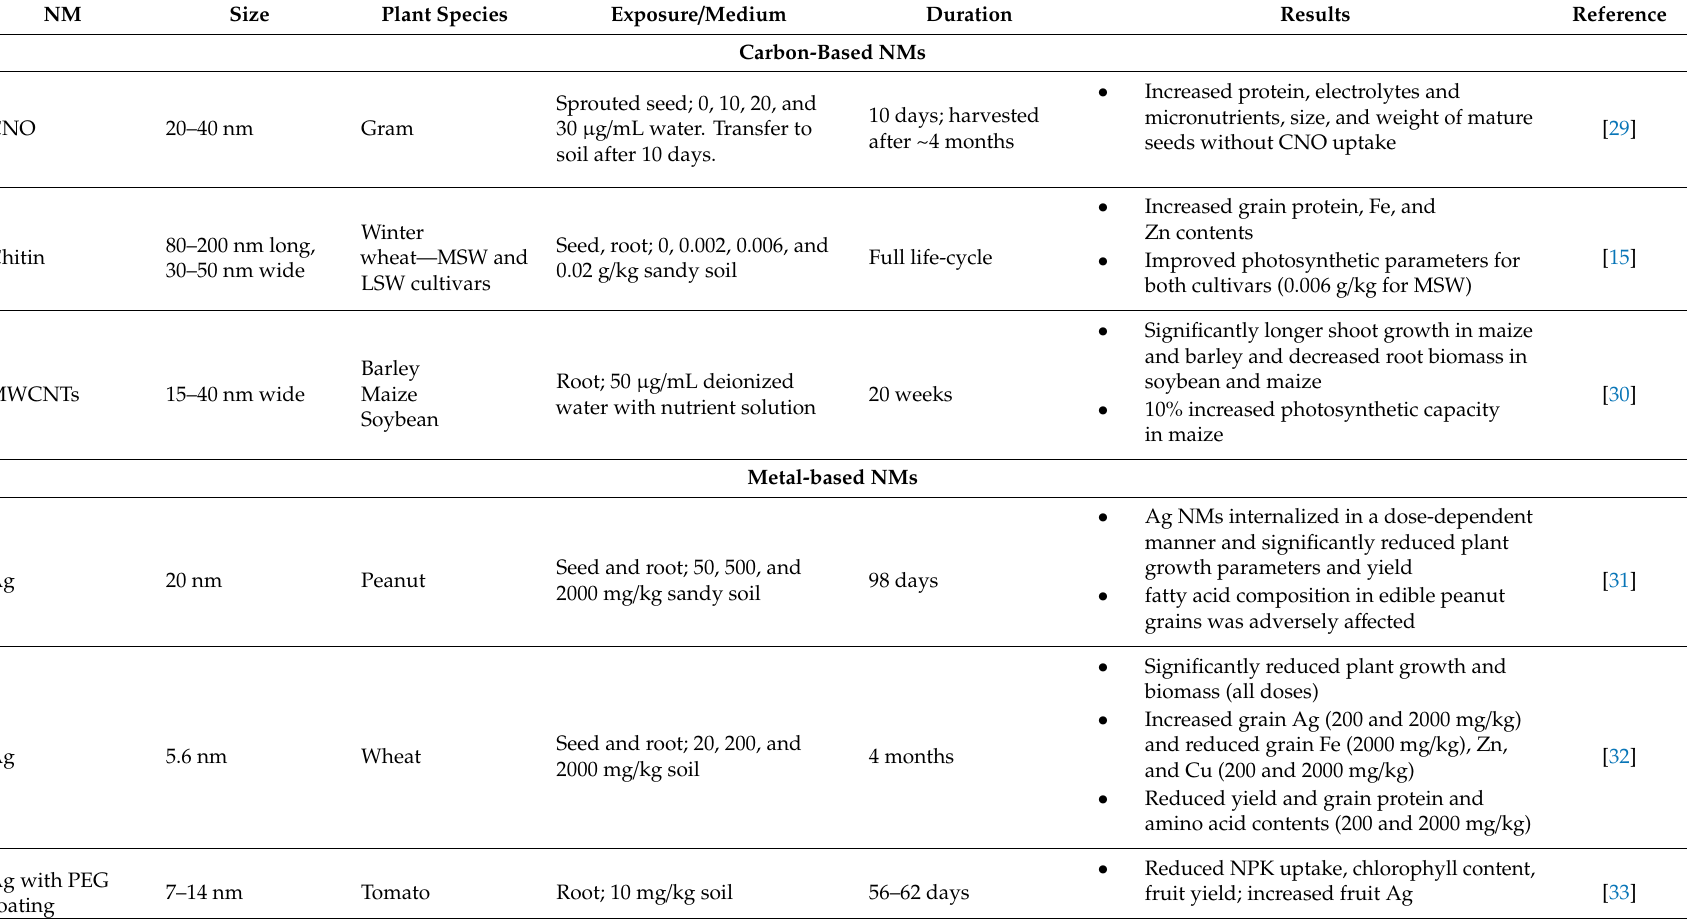
Table 1. Summaries of engineered nanomaterial (ENM) e ff ects on agricultural plant yield and / or nutritional contents documented in recent papers from 2017 and